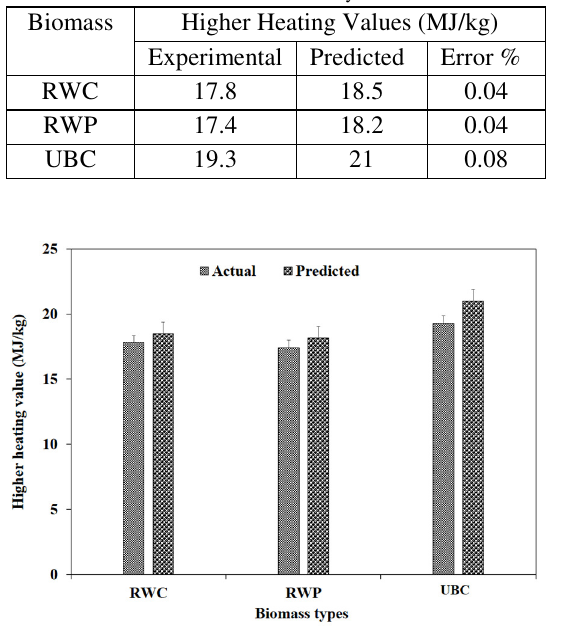
Fig. 3: Comparison of Measured HHV with